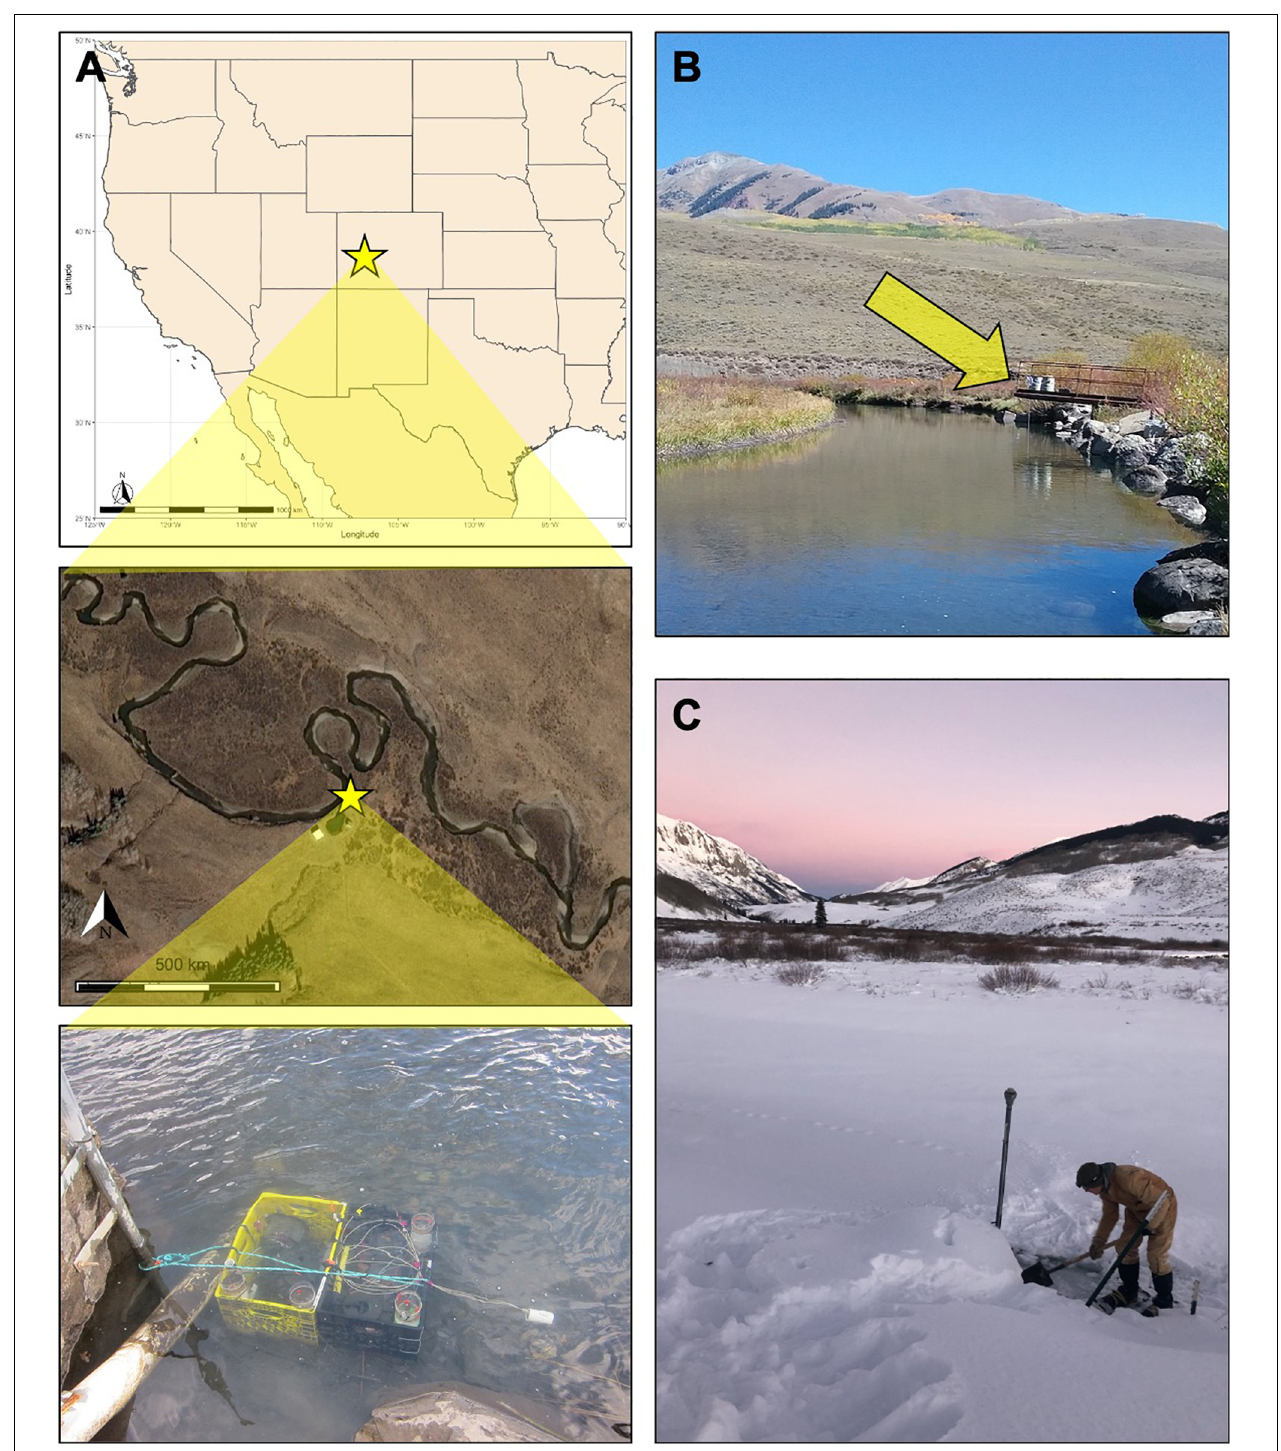
FIGURE 1 | (A) Map of ER depicting the OsmoSampler deployment location and ISCO sampler (yellow star). Photo of OsmoSamplers anchored to the streambed using plastic crates taken during retrieval (September 2018). (B) View of the ISCO sampler (yellow arrow) from the location of the OsmoSampler package, approximately 30 m downstream. (C) Photo of ER during the wintertime retrieval of the BOSS sampler (December 2018). The post protruding from the snow cover marks the location of the OsmoSampler package.